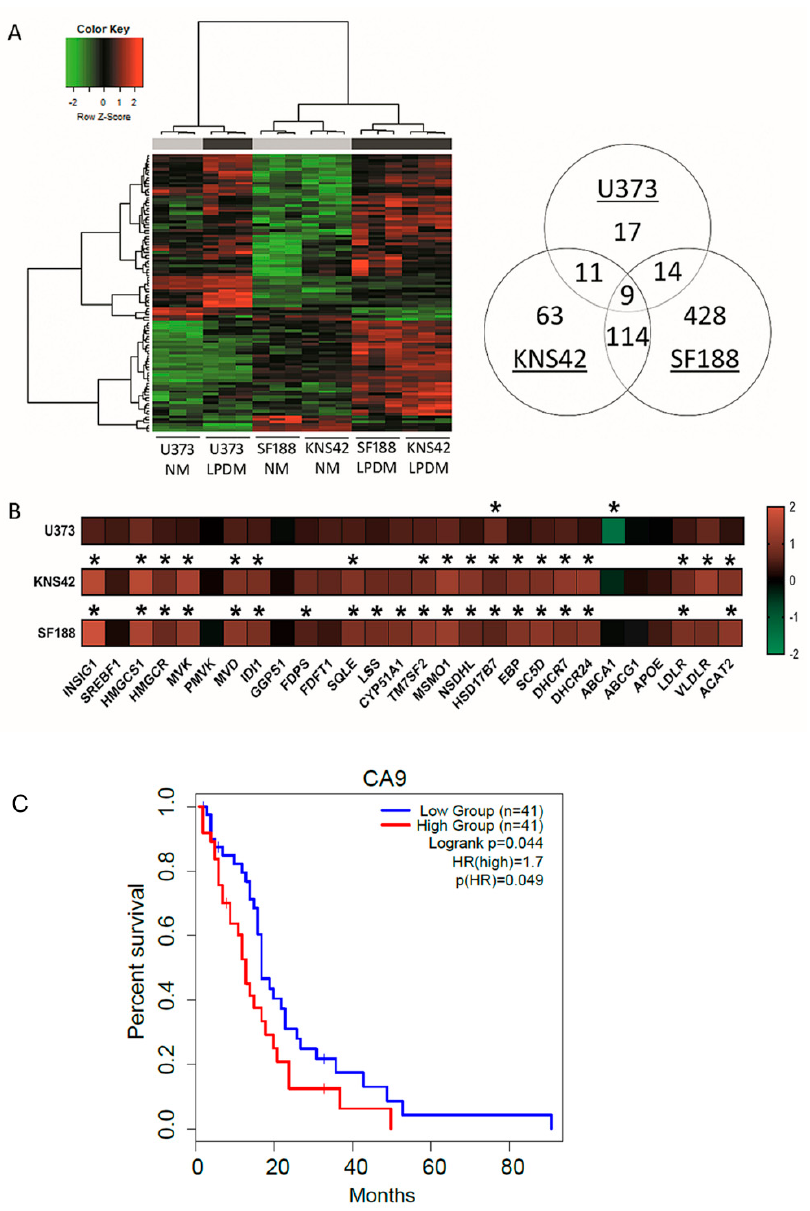
Figure 2. Cholesterol metabolism-related transcriptomic signatures induced by lipoprotein starvation. ( A ) Hierarchical clustering analysis of U373, KNS42, and SF188 diffuse glioma cells cultured under lipoprotein-replete (grey bar) or -deplete (black bar) conditions. Venn diagram (right) indicates the number of differentially expressed genes under lipoprotein-deplete conditions shared across the three diffuse glioma cell lines. ( B ) Heatmap representation of cholesterol metabolism-related gene expression for each of the three diffuse glioma cell lines cultured under lipoprotein-deplete conditions. Colour scale represents log2 fold change gene intensity values. Results are the mean of n = 3 independent replicates. Statistical evaluation of differences between lipoprotein -replete or -deplete between the two culture conditions was performed by implementing a Bayesian linear model using the R package limma and correcting for multiple comparisons: * p < 0.05. ( C ) Kaplan–Meier curve representing the overall survival outcome between CA9 -High and CA9 -Low groups based upon TCGA adult GBM data. Table 1. Gene ontology analysis of differentially expressed genes in U373, KNS42 and SF188 diffuse glioma cells starved of lipoproteins.